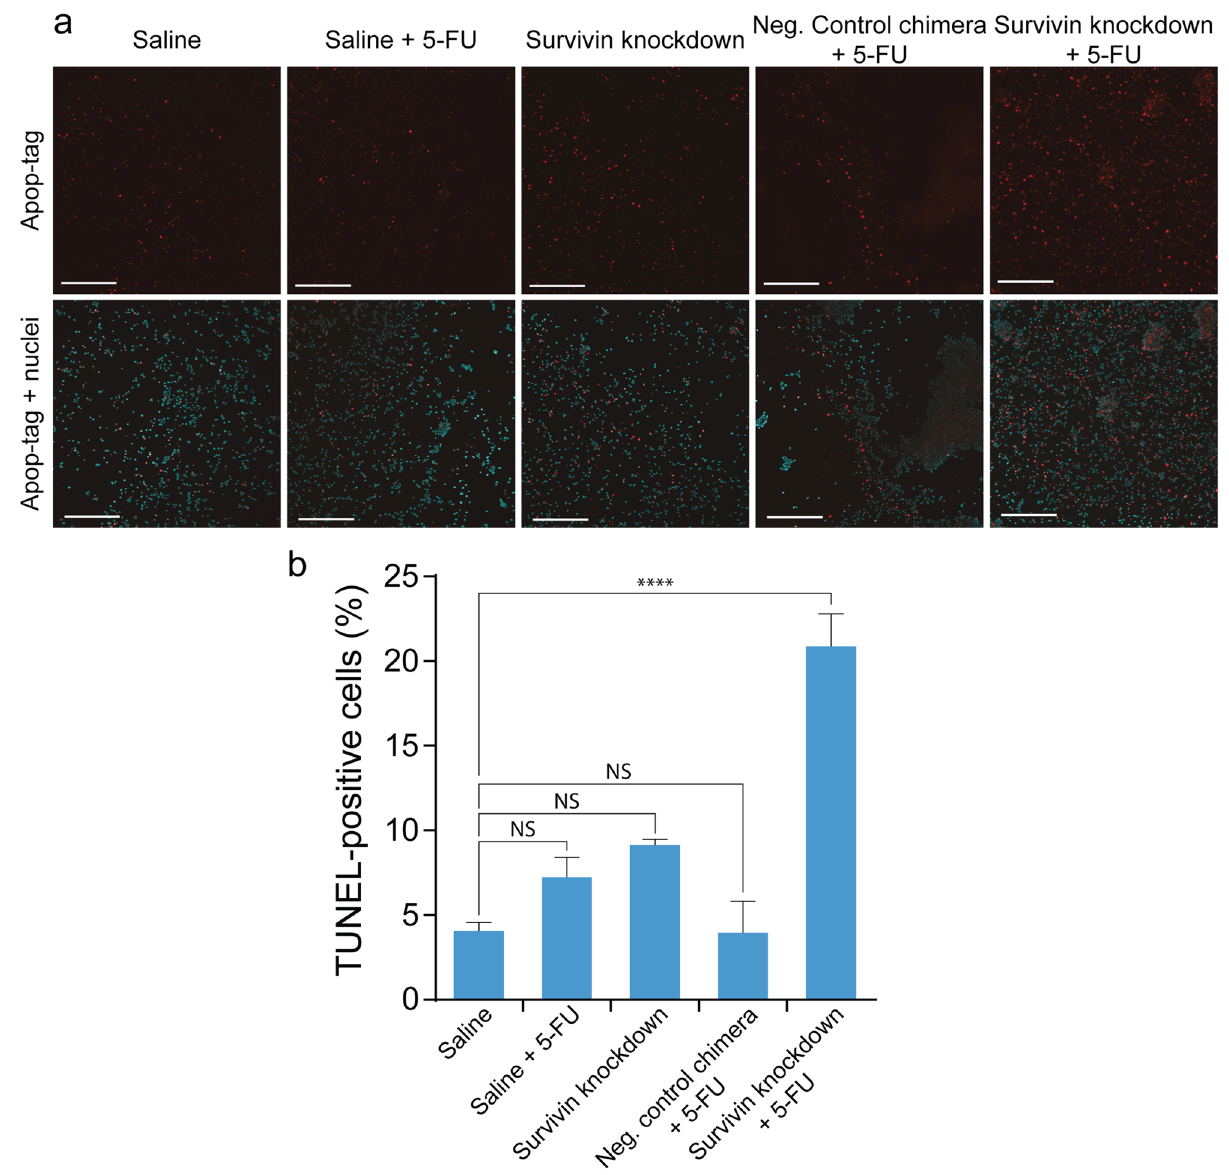
Figure 2. Survivin knockdown in vivo enhances 5-FU-induced apoptosis in HT-29 tumour cells. ( a ) Representative images of TUNEL apoptosis assay on dissociated HT-29 xenograft tumours after in vivo treatment with chimera and 5-FU. NOD/SCID mice bearing HT-29 tumours (60 mm 3 ) were treated intravenously with 3 injections of 2 nmol/mouse of chimera with or without 3 additional treatment of 30 mg/kg of 5-FU. Two days after the final treatment, tumours were dissociated by collagenase digestion and subjected to TUNEL apoptosis assay. ( b ) Percentage of apoptotic cells in treated tumours. Data shown are means ± SEM, n = 3. **** p < 0.001. NS, no statistically significant